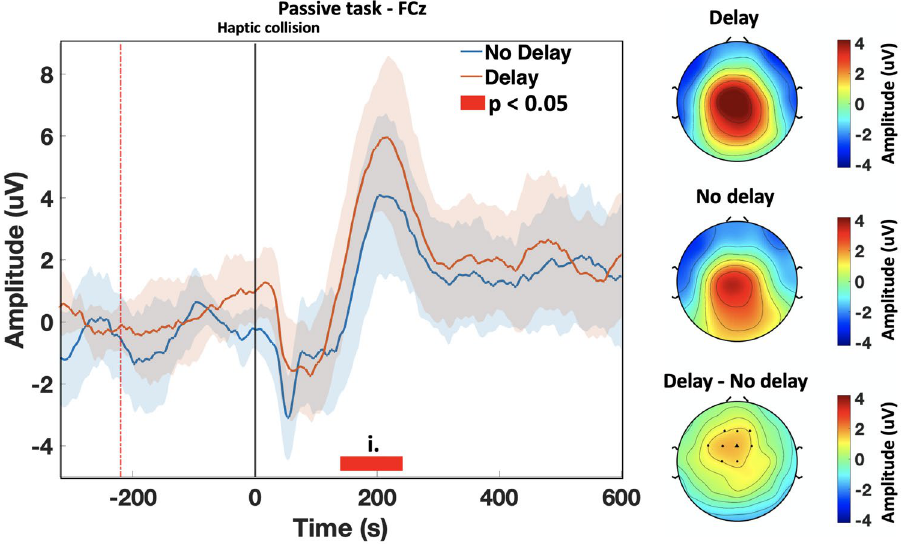
Figure 7. The ERP onset at 0 ms represents the haptic collision event and is denoted by a grey (solid) vertical line. A P200 peak is observed at FCz and surrounding electrodes. The P200 peak is in response to the haptic collision; it is delayed by 220 ms in accordance with the delayed haptic stimulus (orange). A higher mean amplitude peak is observed under the presence of haptic delay compared to the synchronous case with ( p < 0.05 , randomization test, FDR corrected; t range = [140–240 ms]). Thick waveforms represent the mean ERP (across trials and participants), while the shaded areas represent the standard deviation for each condition. The topography plot (right panel) for the delayed condition shows a stronger activation around the central cortex when compared to the synchronous condition. The difference topography plot denotes the channels at which a statistically significant difference was observed; FCz is marked as a triangle. All topography plots represent the mean activation between 140 and 240 ms.